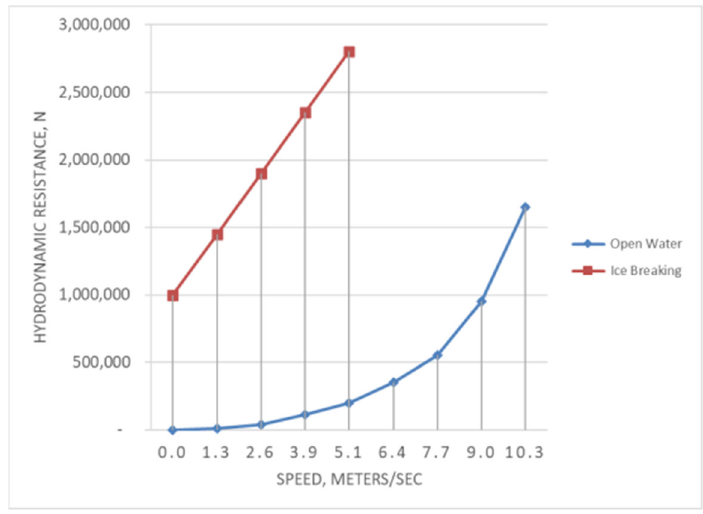
Figure 9. Hull resistance curves.